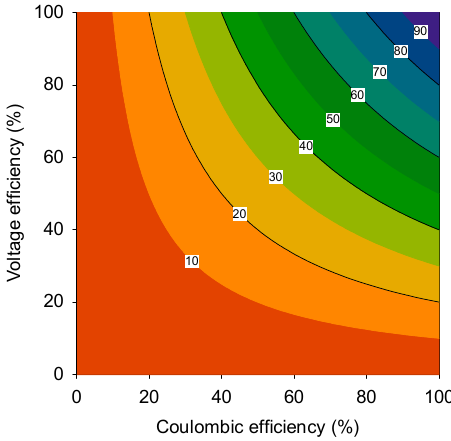
Figure 1. The overall efficiency of a microbial fuel cell (MFC) (contour lines in figure) plotted as a function of the voltage efficiency (%) and the Coulombic efficiency (%). To be competitive with anaerobic digestion, an overall energy efficiency of at least 30% should be achieved (adapted from [12]).